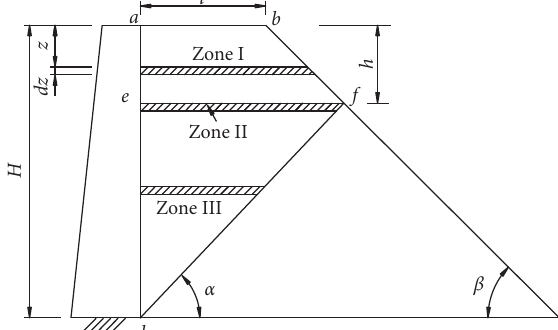
Figure 2: Calculation model of active earth pressure.